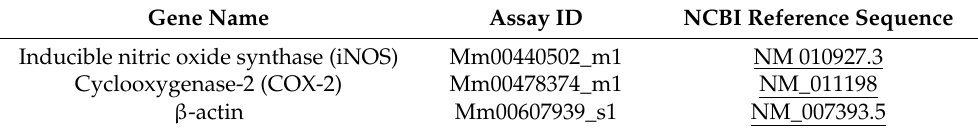
Table 1. Gene name, assay ID, and NCBI reference sequence in quantitative reverse transcription polymerase chain reaction (RT-qPCR).